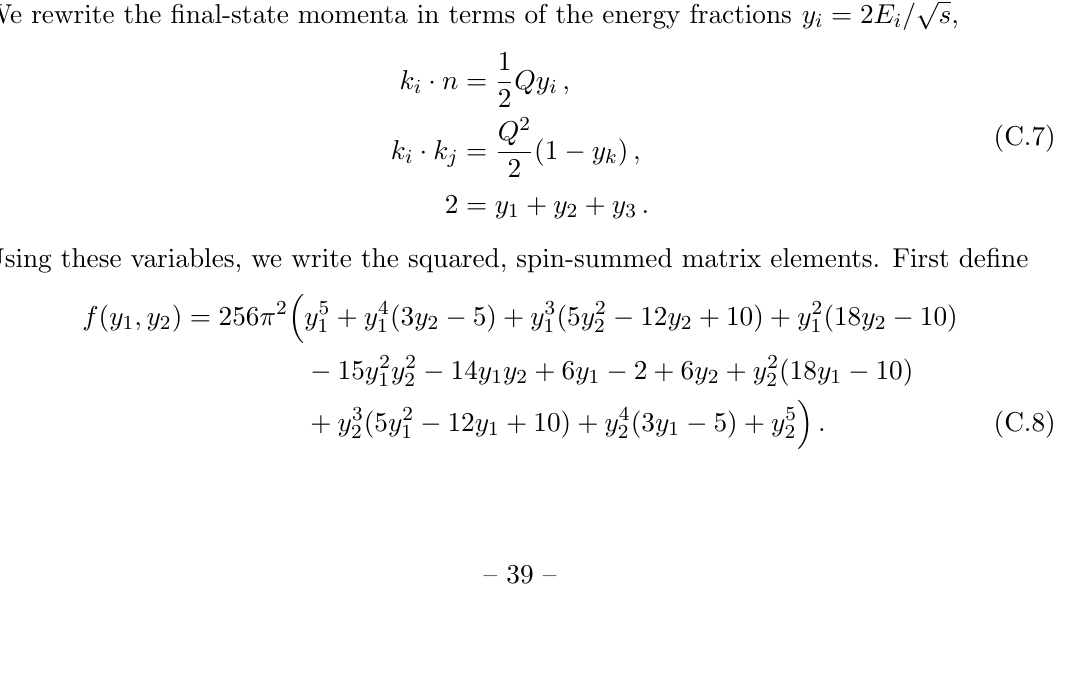
H ggg and (d,e) e + e (cid:0) ! !